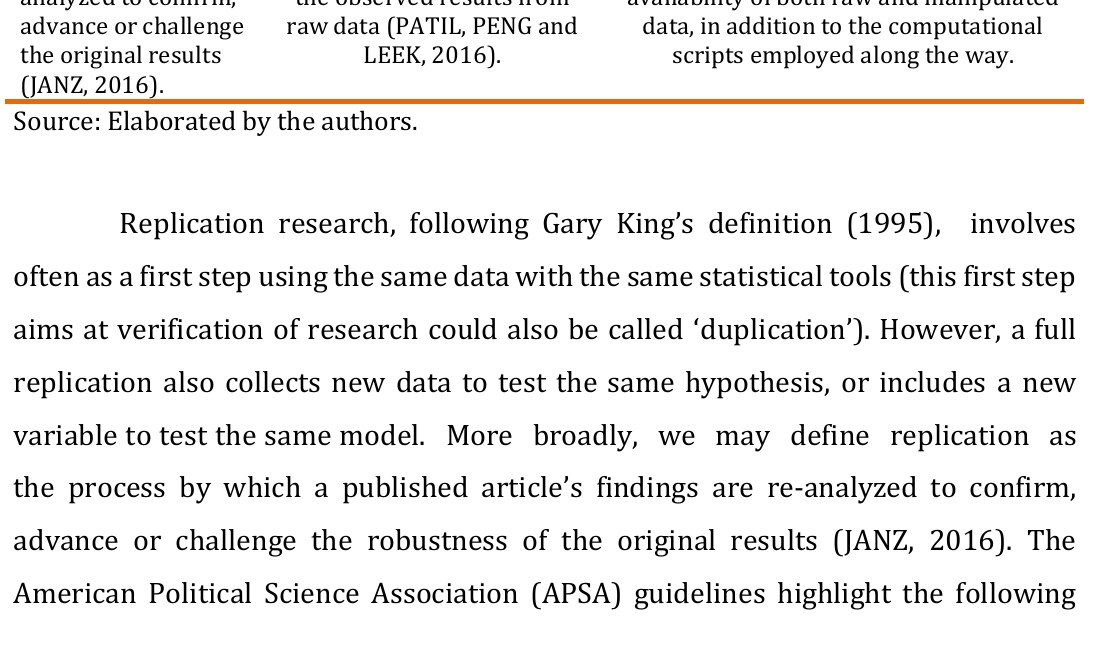
Table 01. Replication, reproducibility and transparency Replication Reproducibility Transparency Process by which a findings are re- analyzed to confirm, advance or